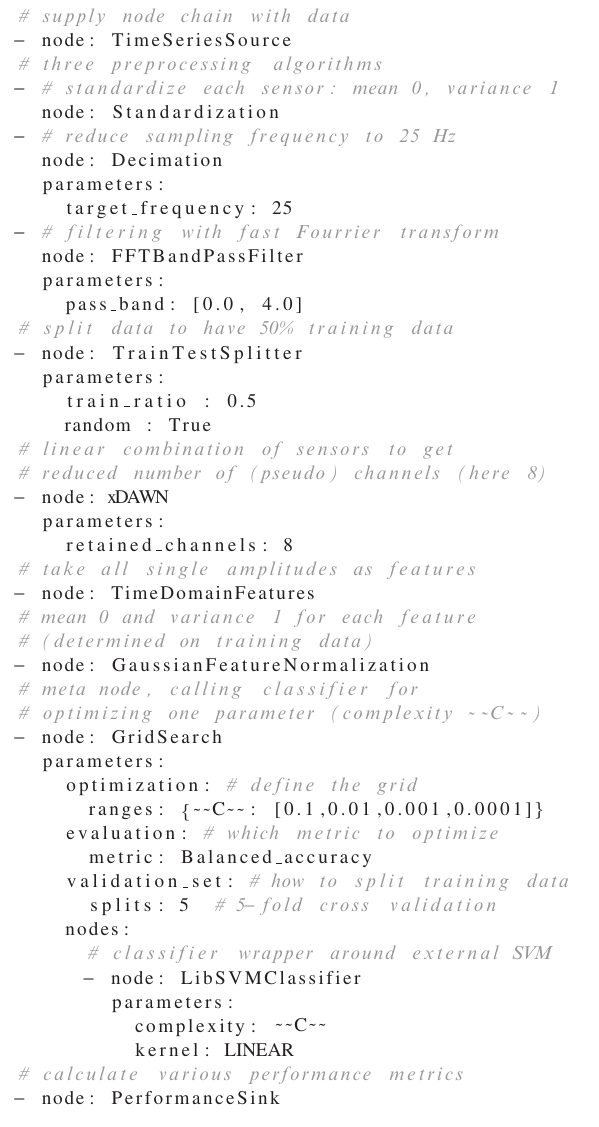
FIGURE 4 | Node chain example file. Comments are denoted by a “#”. For further explanation see section